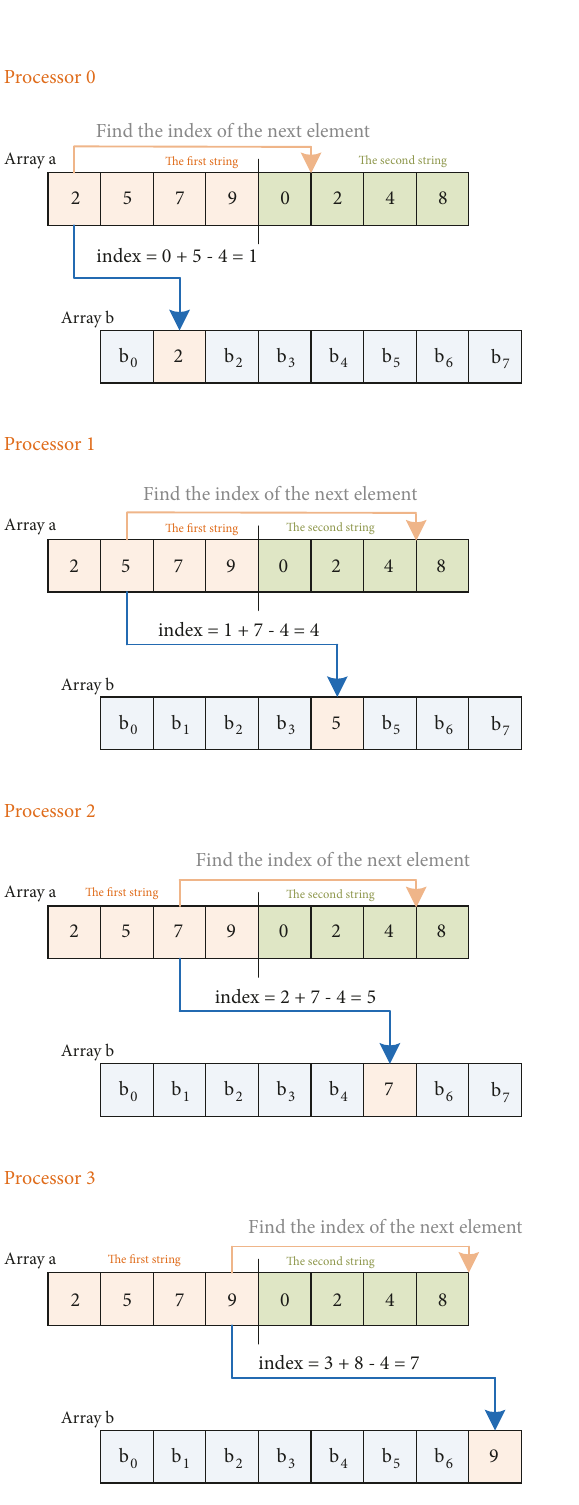
Figure 3: Model of the applied flexible sorting for the number of processors for the insertion of elements into the array b : processor 𝑃 𝑎 0 sorts element 0 into the array b , processor into the array b , processor 𝑃 2 sorts element 𝑎 2 into the array b , etc.